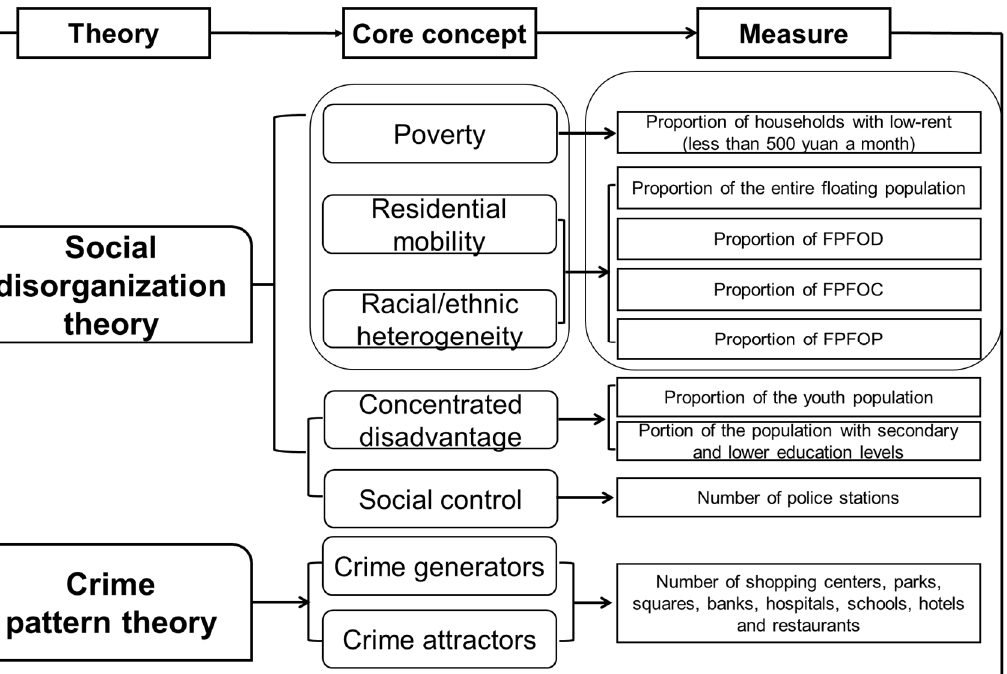
Figure 1. Schematic diagram of conceptual framework.